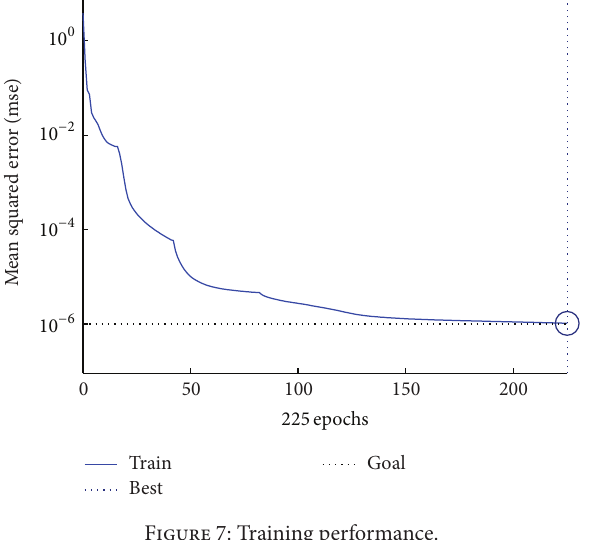
Figure 7: Training performance.